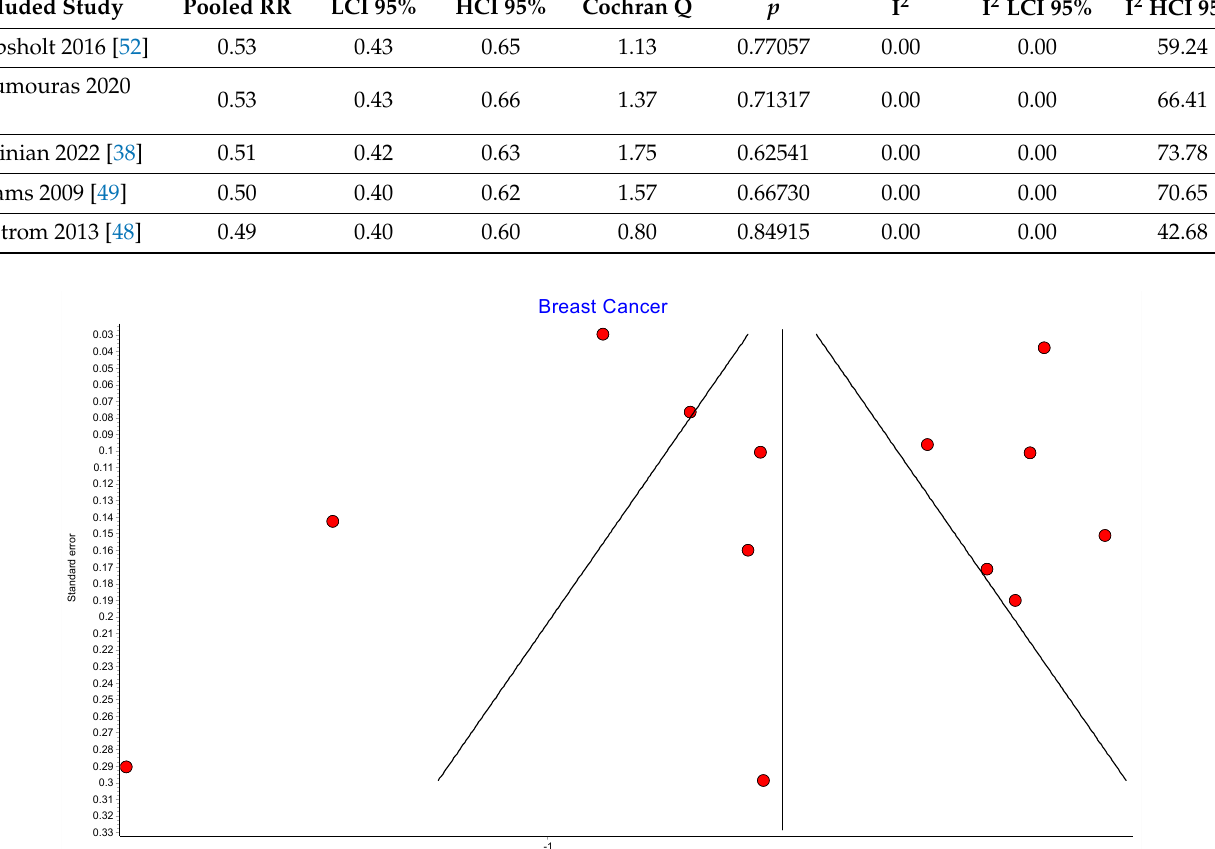
Figure A4. Overall breast cancer random e ff ects model funnel plot.